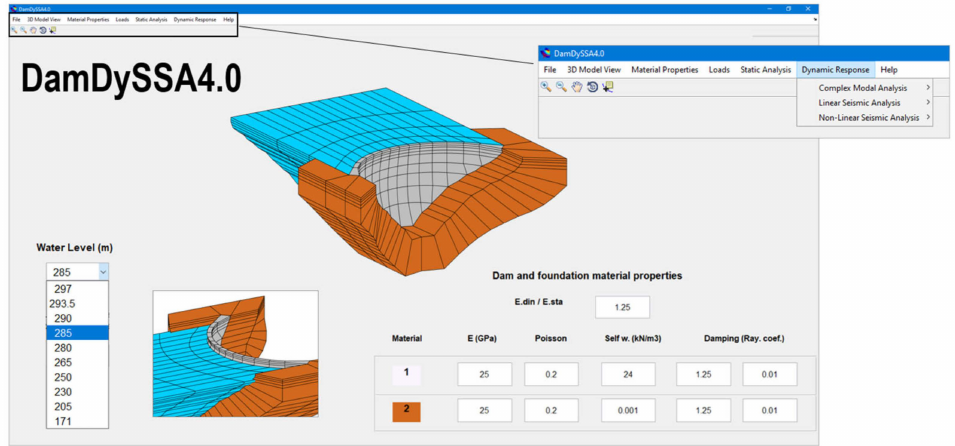
Figure 4. DamDySSA: finite element program for dynamic analysis of concrete dams. User